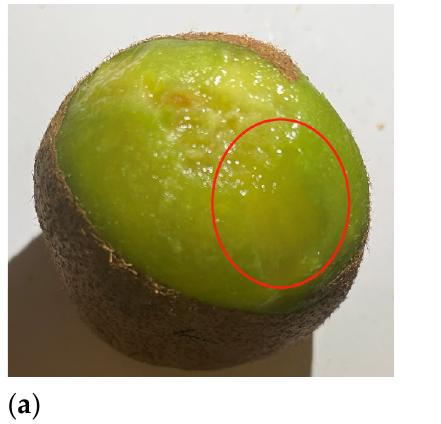
Figure 10. Kiwifruit fall bruise diagram. ( a ) Actual fall; ( b ) Simulated falls. Note: The red circle is the bruise.